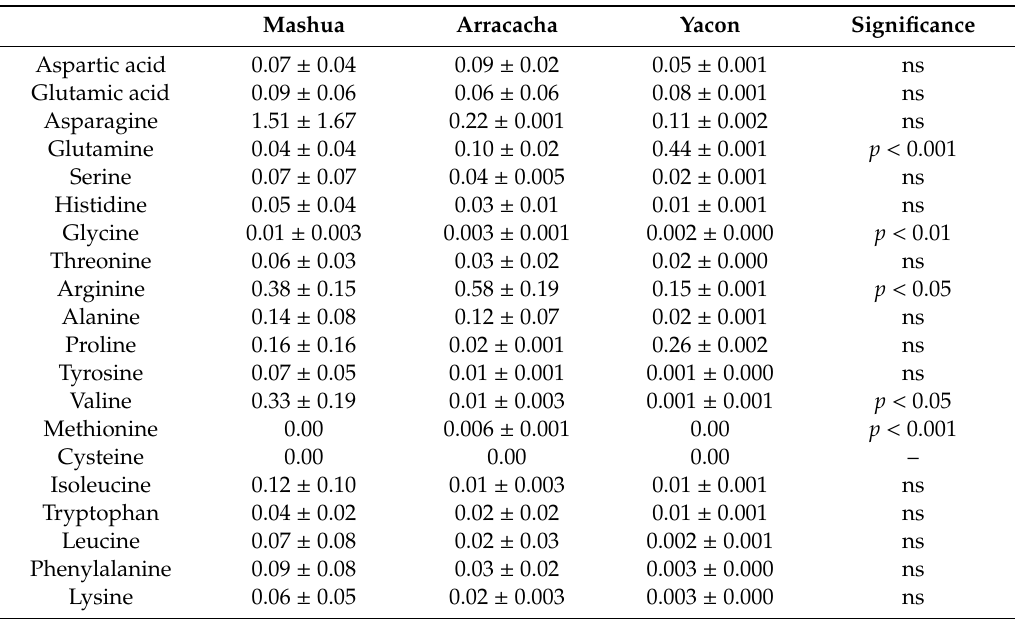
Table 8. Free amino acids in mashua, arracacha, and yacon from Bolivia and Peru (in g 100 g sample − 1 ) and statistical significance of di ff erences among species. Means of di ff erent cultivars (mashua, 7; arracacha, 2; yacon, 2) ± standard deviation. Mashua Arracacha Yacon Significance